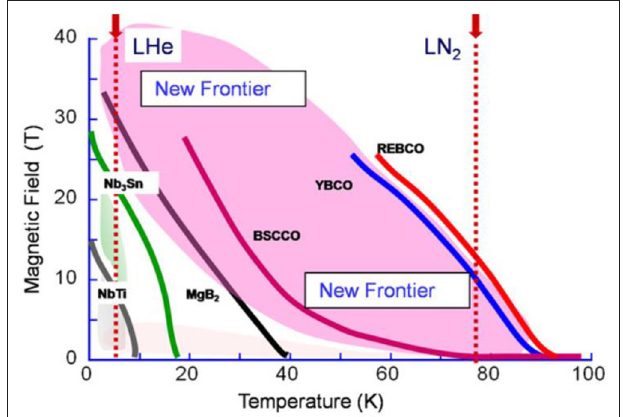
FIGURE 3 | Variation of irreversibility field with temperature for different superconductors including HTS, MgB 2 , metallic compounds, and alloys. The coated conductor technology including APC methodology has opened new frontiers of superconductivity applications in the temperature range of 5–77K. Reproduced from Matsumoto and Mele [20], with the permission from IoP